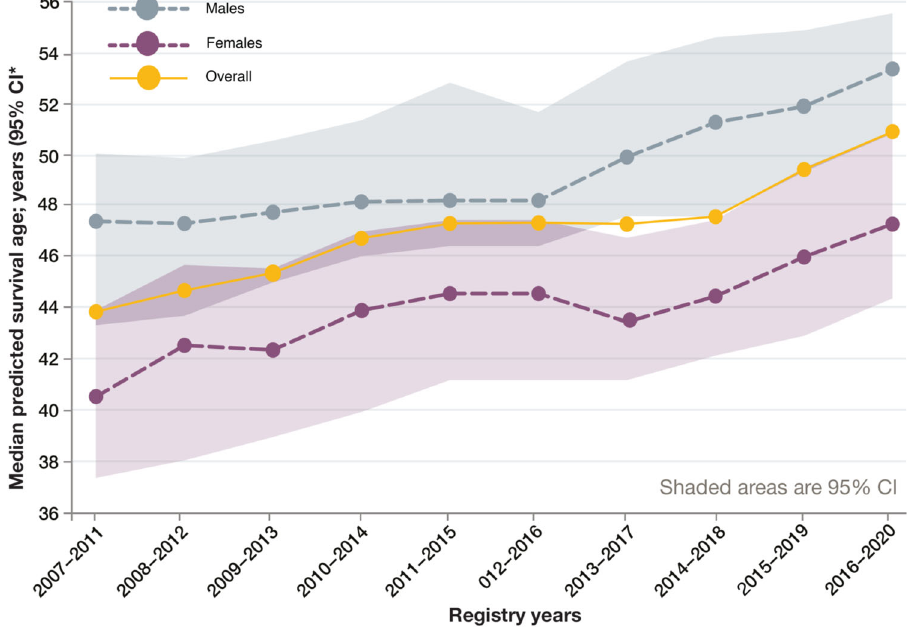
Fig. 1 | Improvementsin median predictedsurvivalin UK pwCF over recent years. From the CFTrust Patient RegistryReport (https://www.cystic fi brosis.org.uk/sites/ default/ fi